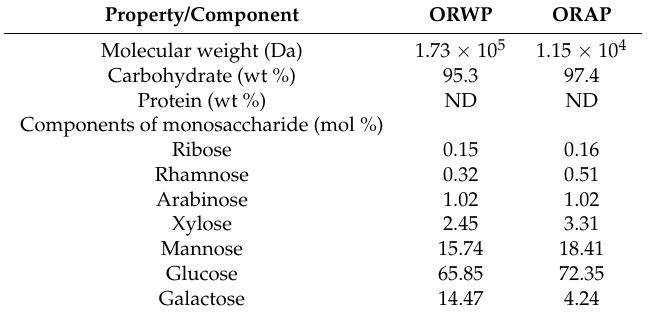
Table 1. General compositions, constituent monosaccharides and molecular weights of ORWP and